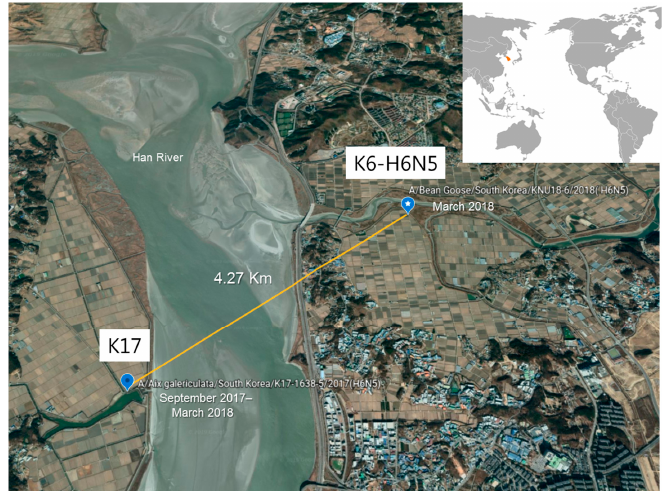
Figure 4. Location of H6N5 isolates in Korea: A/Bean goose/South Korea/KNU18-6/2018(H6N5) and A/Aix galericulata/South Korea/K17-1638-5/2017(H6N5). The map was retrieved from Google Earth. During 2015–2017 in North America, the HA and NA of A/California/H6N5 may have reassorted with other internal gene segments of local AIV residents, thereby transmitting it to Alaska to recruit PB2 for K17, and gathering both PB1 and PB2 to K6 from a donor virus A/Mallard/Alaska/Ah0029066S.2.A/2016 H12N5. The intercontinental transmission may have been facilitated by certain key vector species, such as the northern pintail and mallard, which have wide geographic distribution across Europe, Palearctic, and North America. Somewhere in Russia, near Alaska, the North American-origin H6N5 may have spread to bean geese before being introduced to Korea as K6 (Figure 5B). However, Aix galericulata as a host of K17 is an Asian population that breeds, feeds, and overwinters in lowland eastern China and southern Japan. Therefore, K17 has been suggested to be transferred from migratory birds to other native species before spreading to mandarin ducks in Korea (Figure 5A).